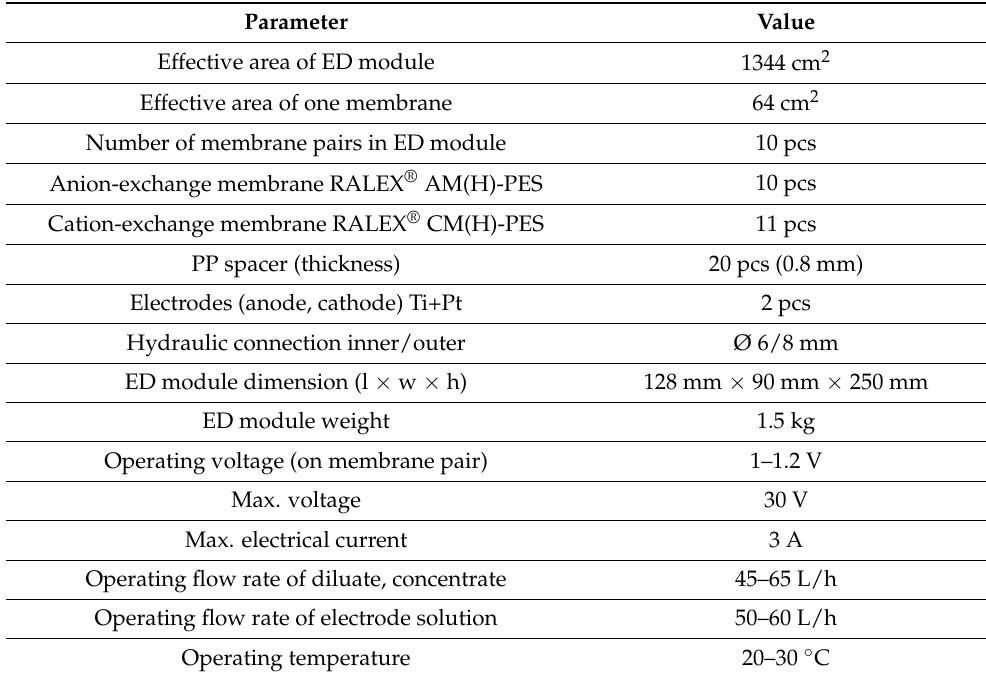
Table 2. ED module specifications and operating working